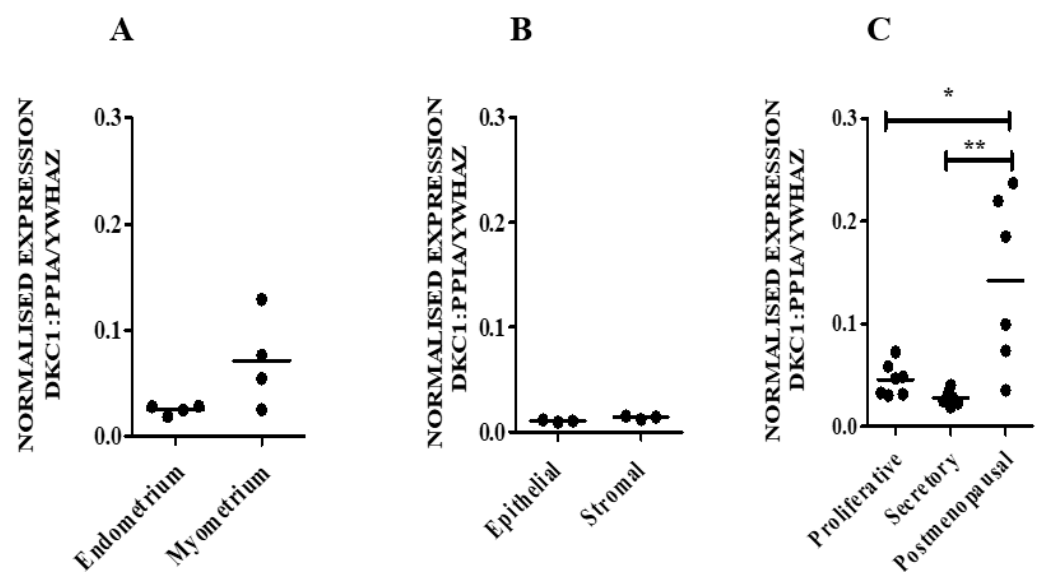
Figure 2. DKC1 mRNA levels in normal human uterus. DKC1 mRNA was measured in the following endometrial samples: ( A ) Endometrium E ( n = 4) versus myometrium (M) ( n = 4). ( B ) Isolated epithelial (Ep) ( n = 3) versus stromal (St) ( n = 3) endometrial cells. ( C ) Proliferative (PP) ( n = 7), secretory phase (SP) ( n = 8) and postmenopausal (PM) ( n = 6) endometrial samples, DKC1 expression was normalised to the geometric mean of peptidylprolyl Isomerase A ( PPIA ) and tyrosine 3-monooxygenase/tryptophan 5-monooxygenase activation protein zeta ( YWHAZ ) reference genes, * p < 0.05, ** p < 0.01.